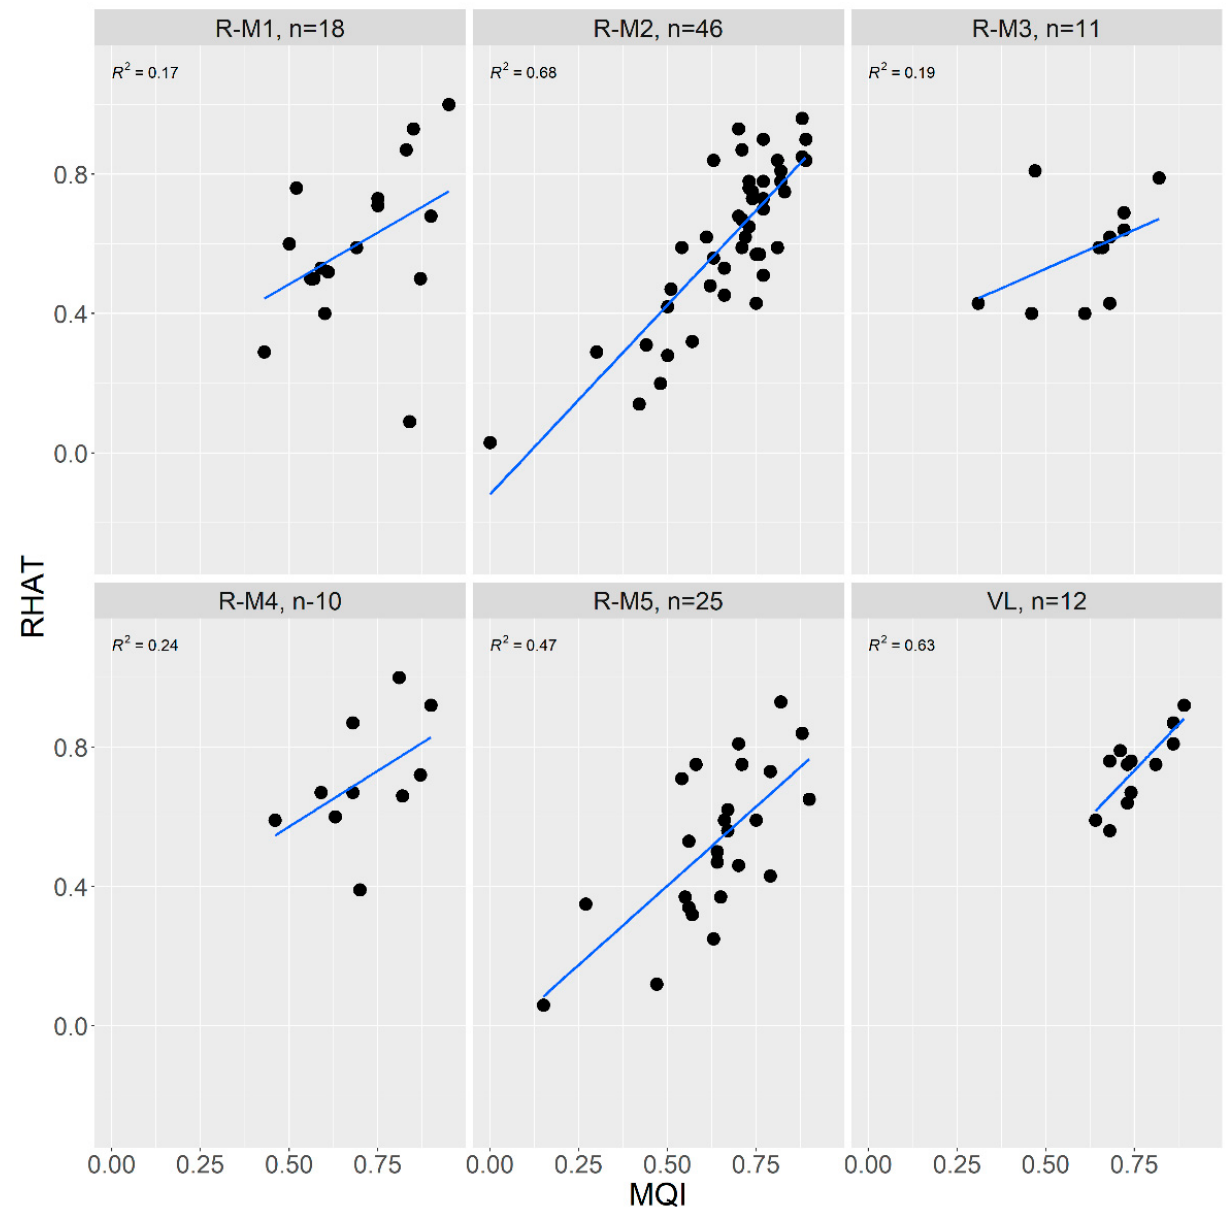
Figure 6. Linear regressions between RHAT and MQI indices per intercalibration river type (ICT). R 2 value is shown on top left of each plot.